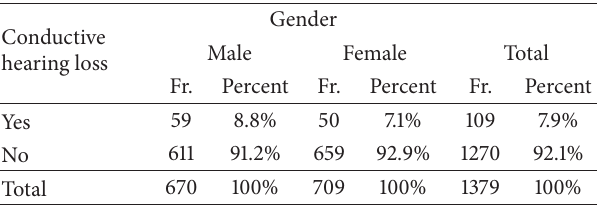
Table 4: Frequency distribution of conductive hearing loss based on gender.